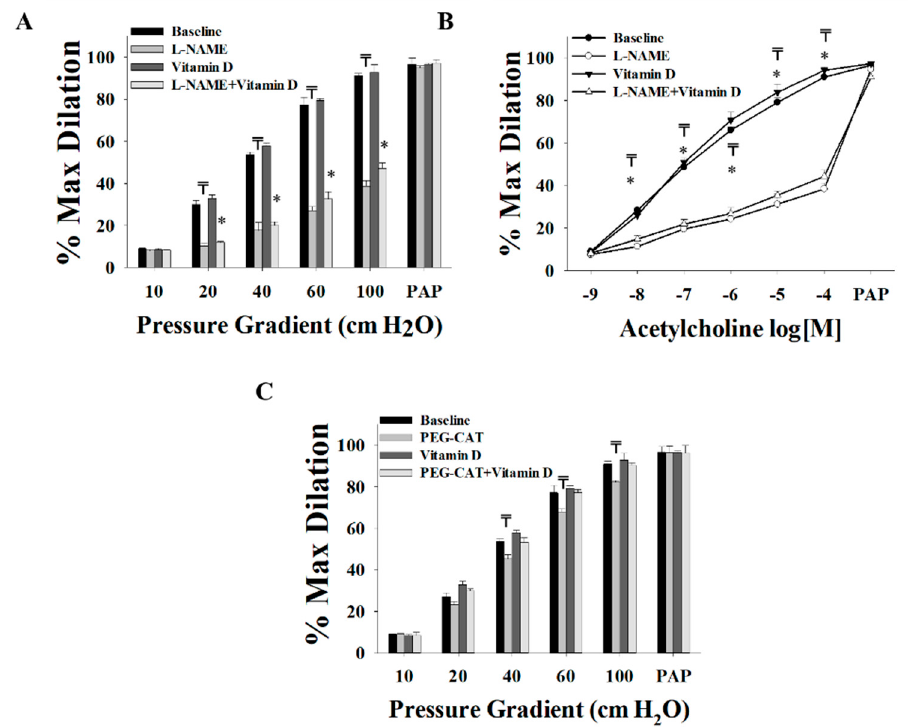
Figure 7. E ff ect of vitamin D, L-NAME, and PEG-CAT on vasodilation of SAT arterioles collected three months after bariatric surgery ( n = 8). FID measurements corresponding to intraluminal pressure gradients of 10–100 cm H 2 O in SAT arterioles at baseline and after incubation with L-NAME, PEG-CAT, vitamin D, vitamin D plus L-NAME, and vitamin D plus PEG-CAT ( A , C ). AchID measurements corresponding to increasing Ach concentrations (10 − 9 to 10 − 4 M) in SAT arterioles at baseline and after incubation with L-NAME, vitamin D, and vitamin D plus L-NAME ( B ). All measures are represented as means ± SE; T p < 0.05 comparing L-NAME or PEG-CAT with baseline, and * p < 0.05 comparing L-NAME + vitamin D with vitamin D alone.